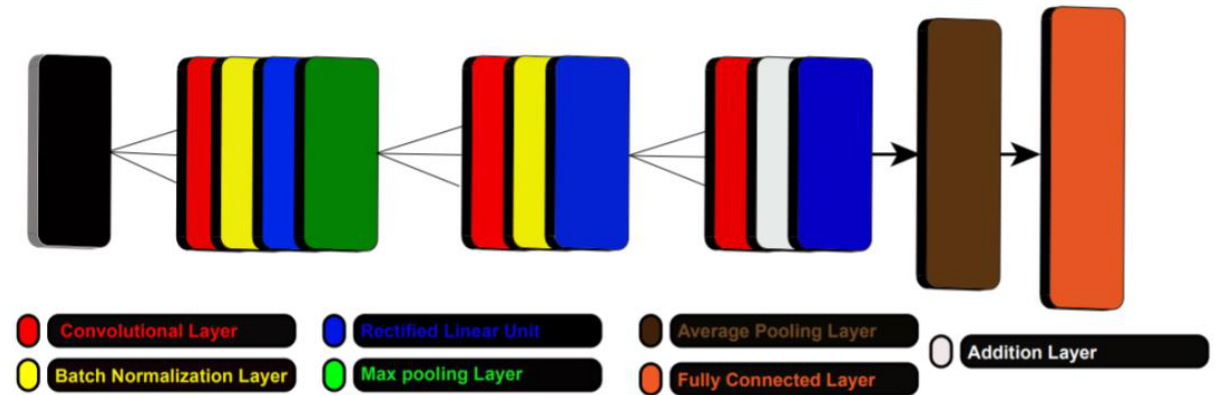
Figure 1. A simple CNN architecture for gait recognition.